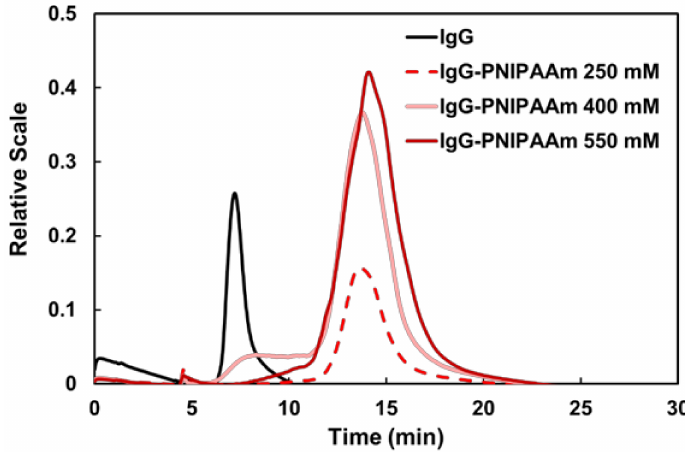
Figure 3. Separation profile of IgG and IgG–PNIPAAm conjugates by FFF. Table 1. Characterization of IgG–PNIPAAm by field flow fractionation (FFF). Monomer Concentration in